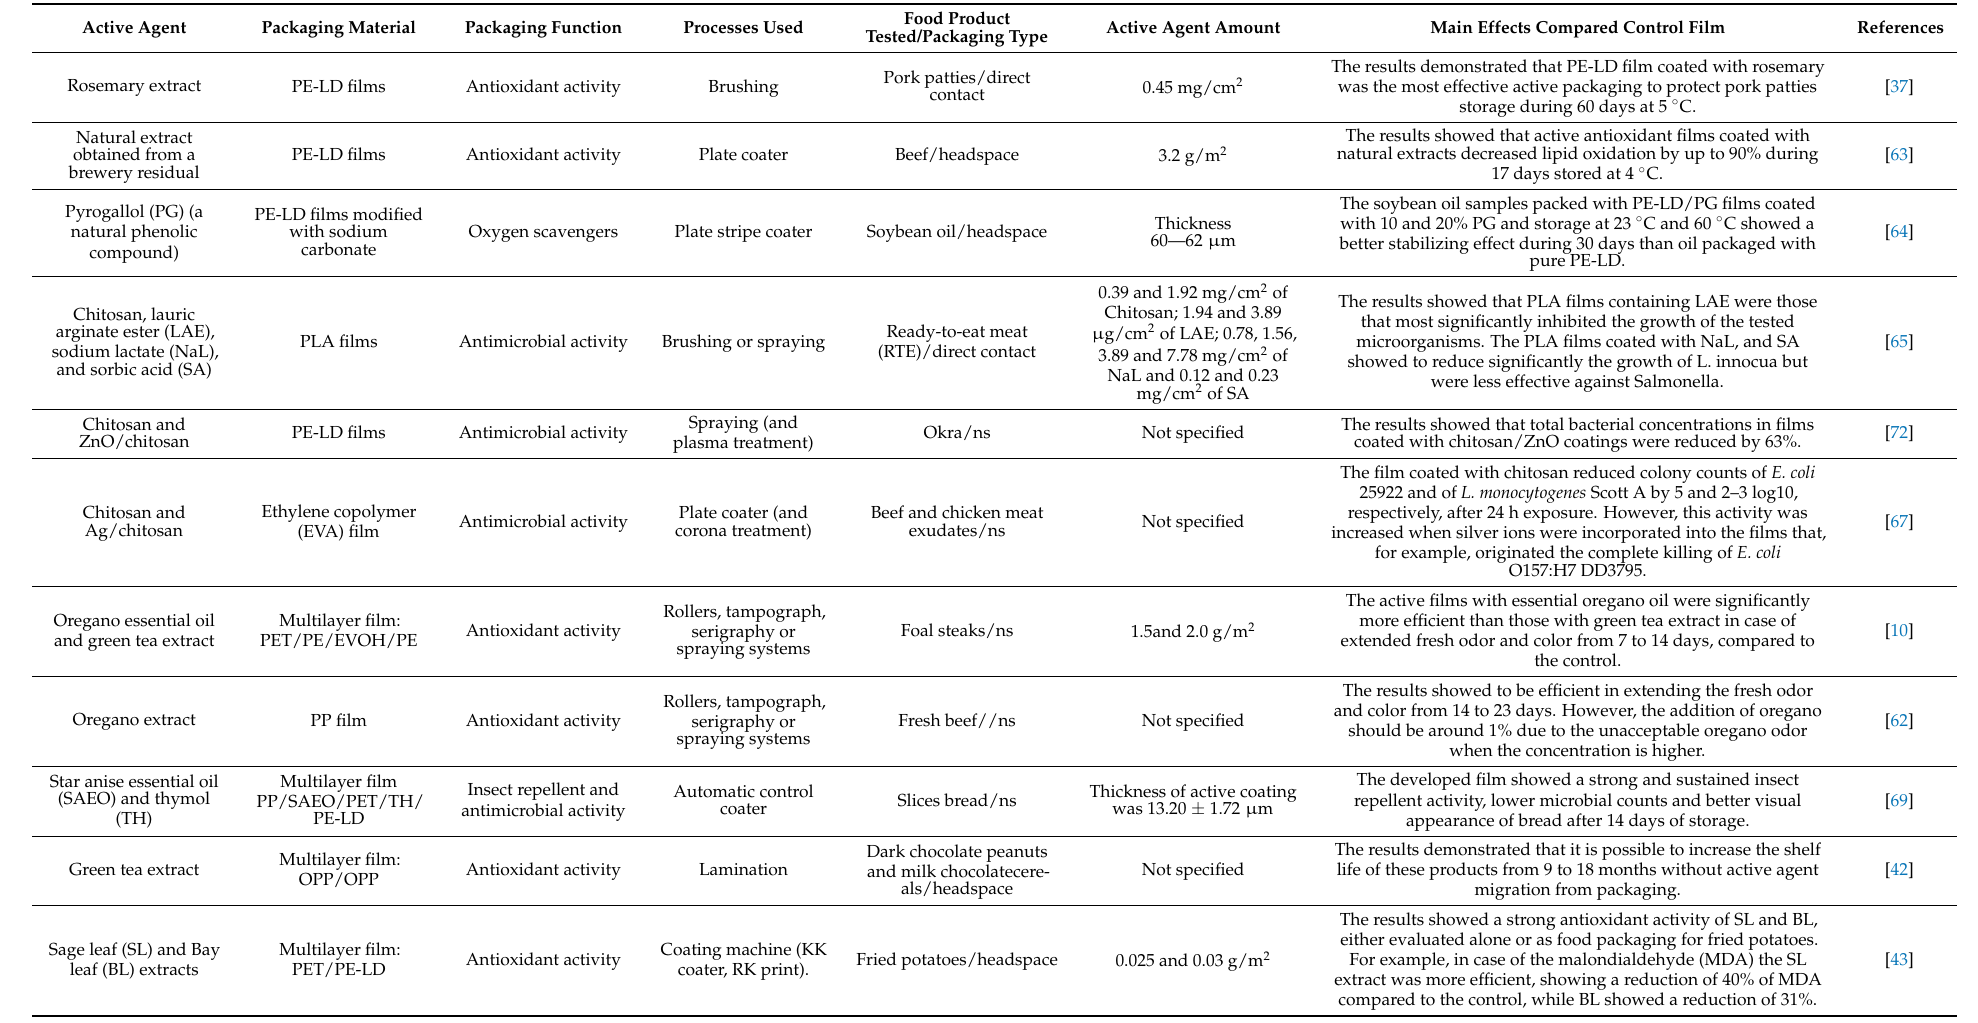
Table 3. Active agents added directly to